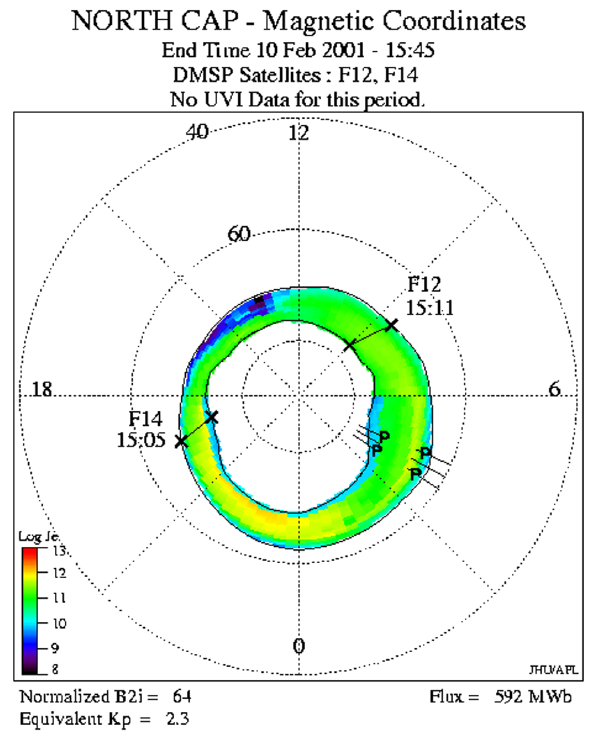
Plate 2 : An example of an OVATION display, combining DMSP boundaries, marked with an “x”, and UAF MSP data, marked with a